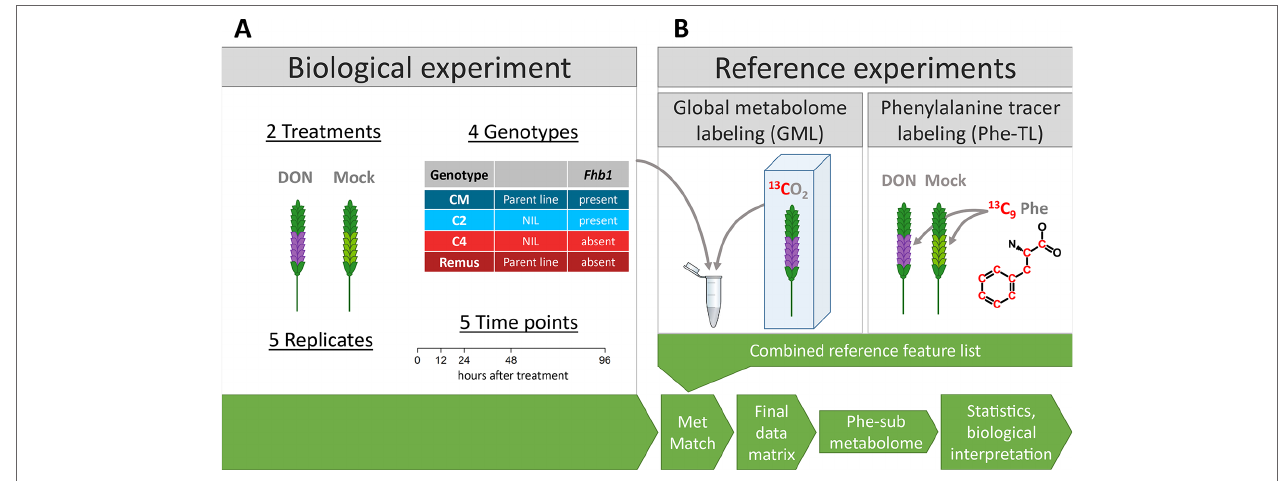
FIGURE 1 | Schematic overview of the experimental setup of (A) the biological experiment and (B) the two reference experiments. The reference feature list generated from metabolites of the reference experiments was matched with data from the biological experiment into the final data matrix that was used for statistics and biological